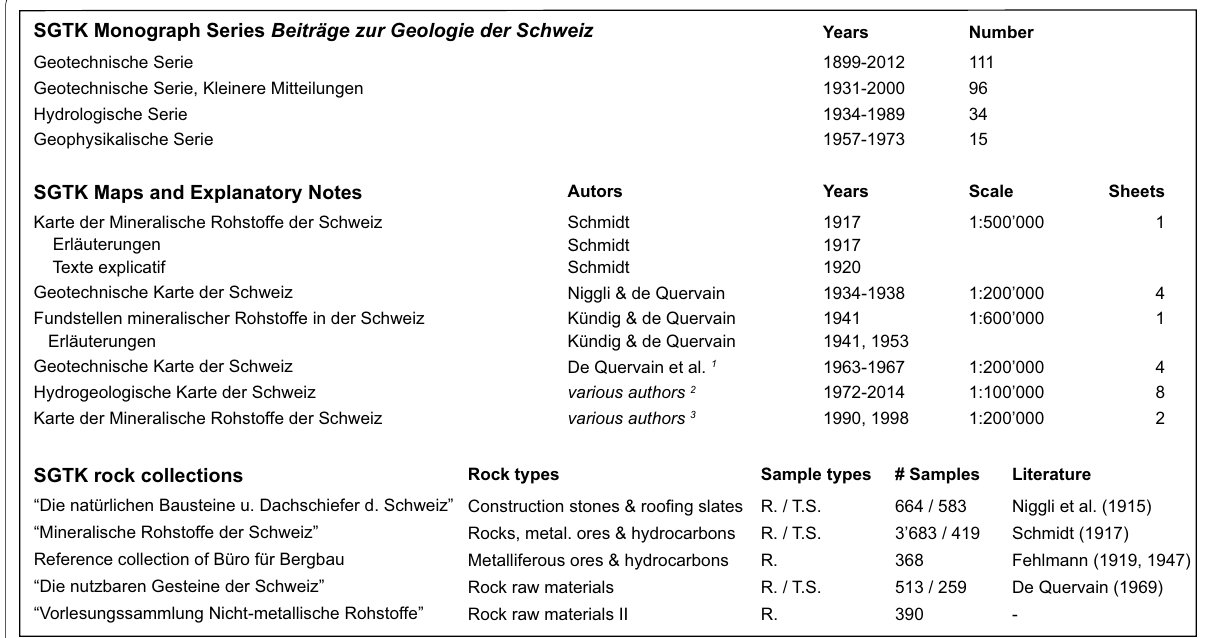
Fig. 16 ( Top ) The four types of monograph series published by SGTK in the Beiträge zur Geologie der Schweiz . ( middle ) Key SGTK Maps and Explanatory Notes. 1 de Quervain et al., (1963, 1964, 1965, 1967). 2 Jäckli and Kempf (1972), Kempf (1980), Jäckli et al. (1985), Pfirter and Hauber (1991), Haering et al. (1993), Pasquier et al. (1999), Pasquier et al. (2006), Hauber et al. (2014). 3 Wenger and Steiger (1990), Cavalli et al. (1998). ( bottom ) Most important SGTK rock collections. Note that the reference collection by C. Schmidt (1917) is stored at the Museum of Natural History in Basel, the others are at ETH Zurich. R.: rock sample, T.S.: thin section. The SGTK monographs Beiträge zur Geologie der Schweiz can be downloaded here: https:// shop. swiss topo. admin. ch/ de/ produ cts/ publi catio ns/ geolo gy/ contr ibuti onsgeo/